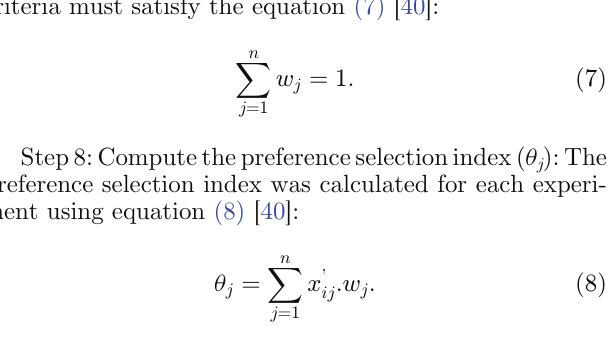
Fig. 4. Effect of I on MRR and TWR in EDM using